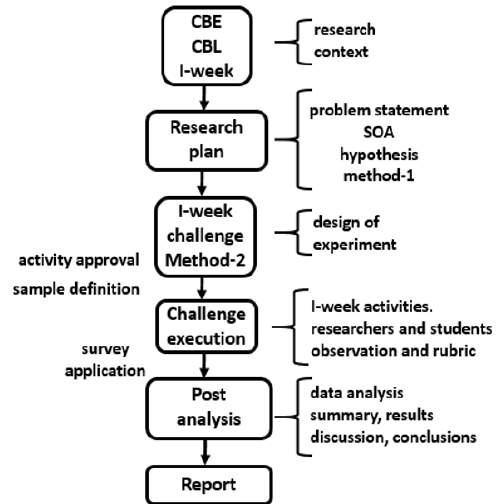
Figure 1. General research process